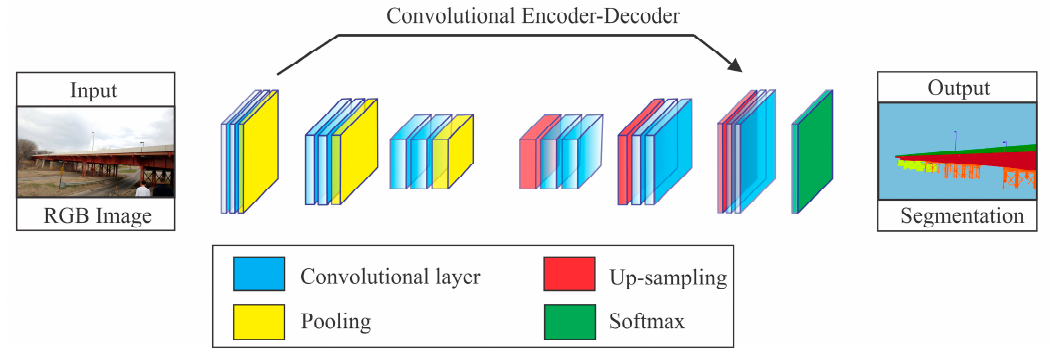
Figure 6. Illustrations of bridge components recognition.